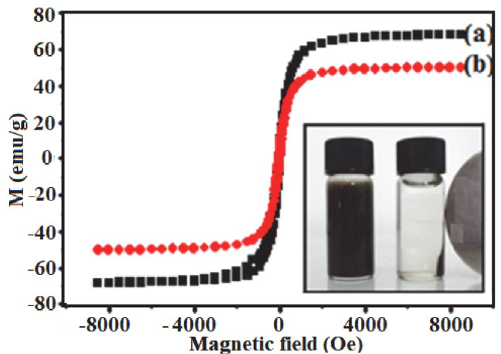
Figure 7. Magnetic hysteresis loops of (a) pure CuFe 2 O 4 and (b) Ag/ CuFe 2 O 4 /rGO at room temperature. The inset image shows the Ag/ CuFe